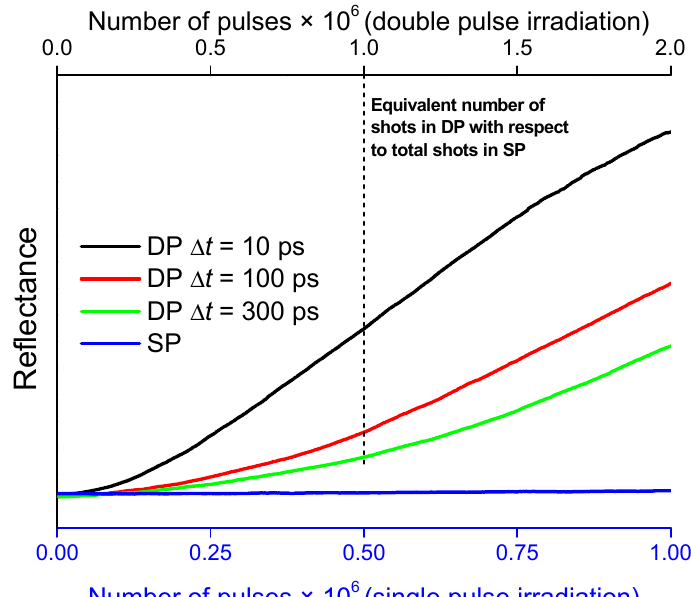
Figure 2. Evolution of the reflectance of a CW He-Ne laser beam as a function of the number of laser pulses for samples prepared by single pulse (SP) and double pulse (DP) irradiation at 10, 100, and 300 ps of interpulse delay. The vertical dashed line indicates the point where an equivalent number of individual laser pulses is achieved in the case of DP irradiation with respect to the total number of pulses in the SP case (1 × 10 6 individual pulses). Note that the total number of pulses is 2 × 10 6 for DP irradiation and 10 6 for SP irradiation.